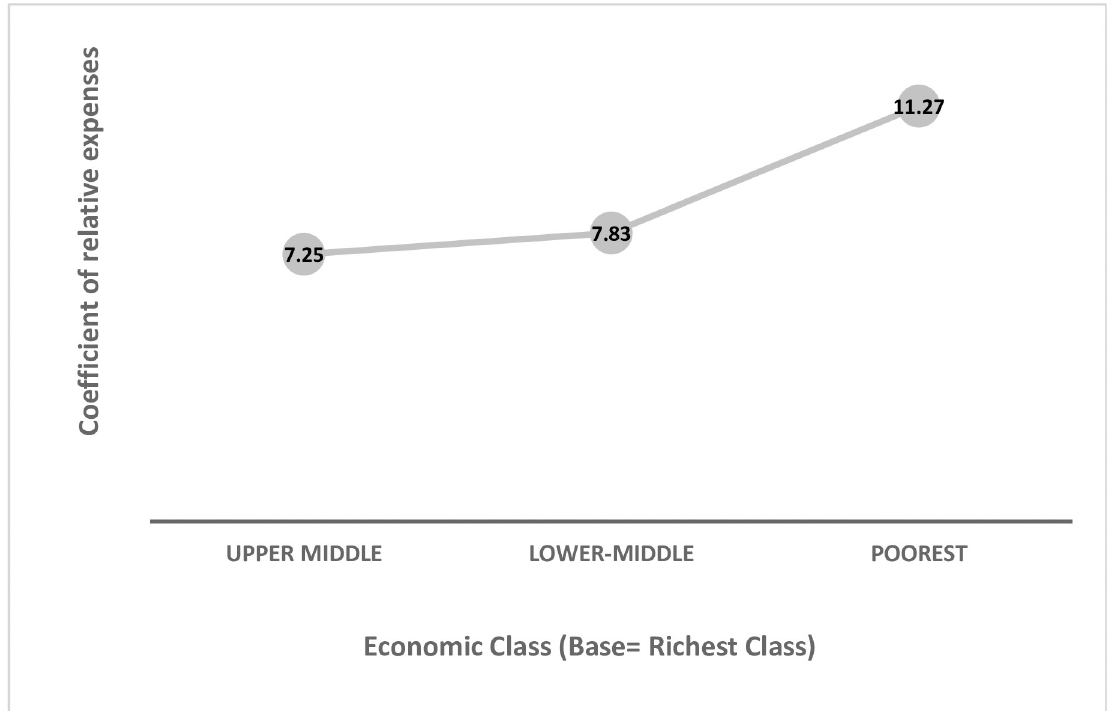
Fig 4. Relative expenditure for care seeking across the economic strata with reference to richest economic class: Findings from linear regression (N = 159).